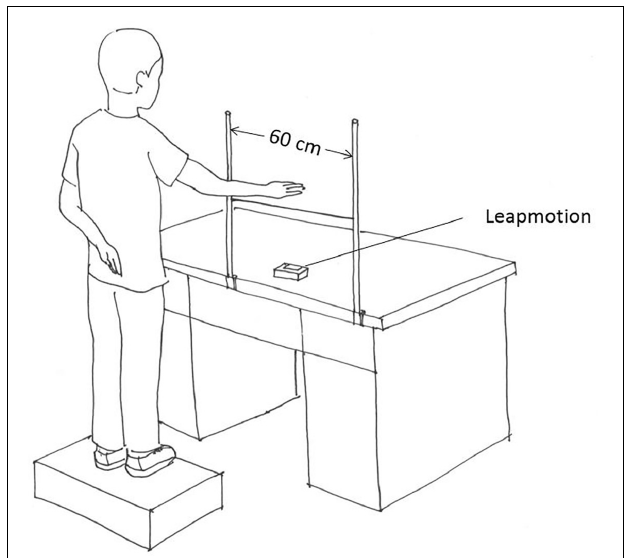
FIGURE 1 | Schematic illustration of the experimental setup.